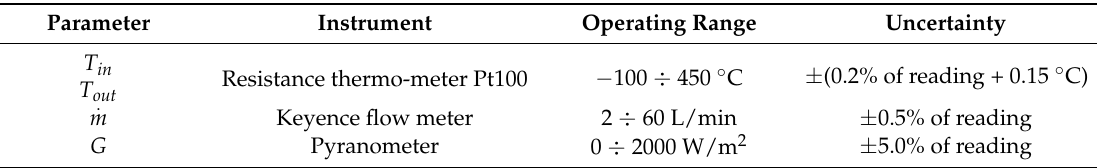
Table 1. Main characteristics of the plant